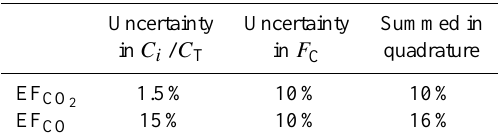
Table B2. Totals and component values of the uncertainty budget for calculating EF CO and EF CO 2